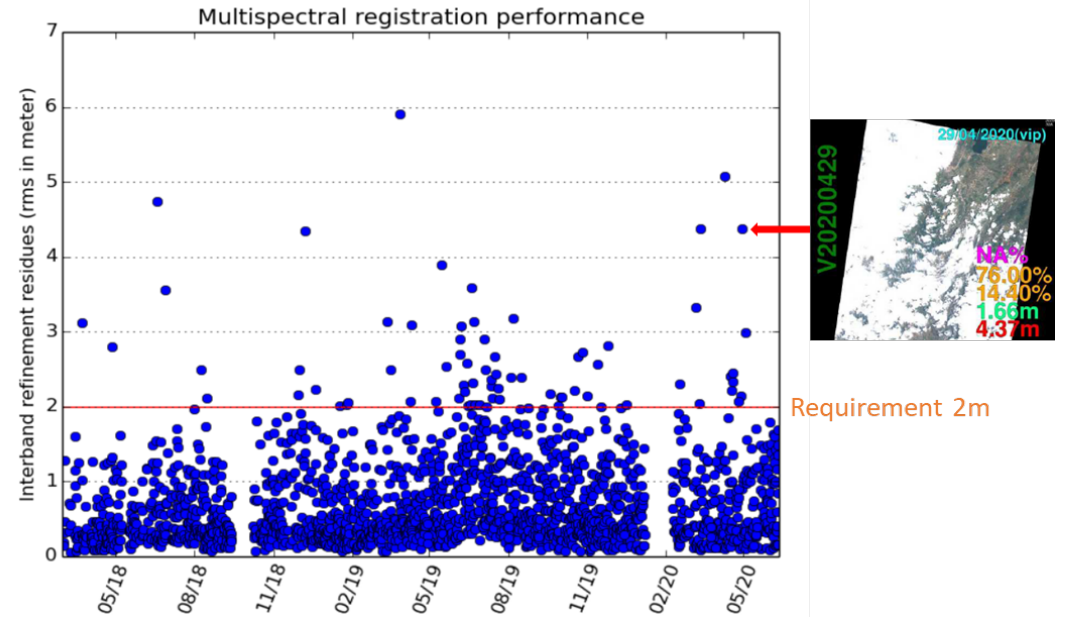
Figure 26. Multi-spectral registration performances through VM01 phase.